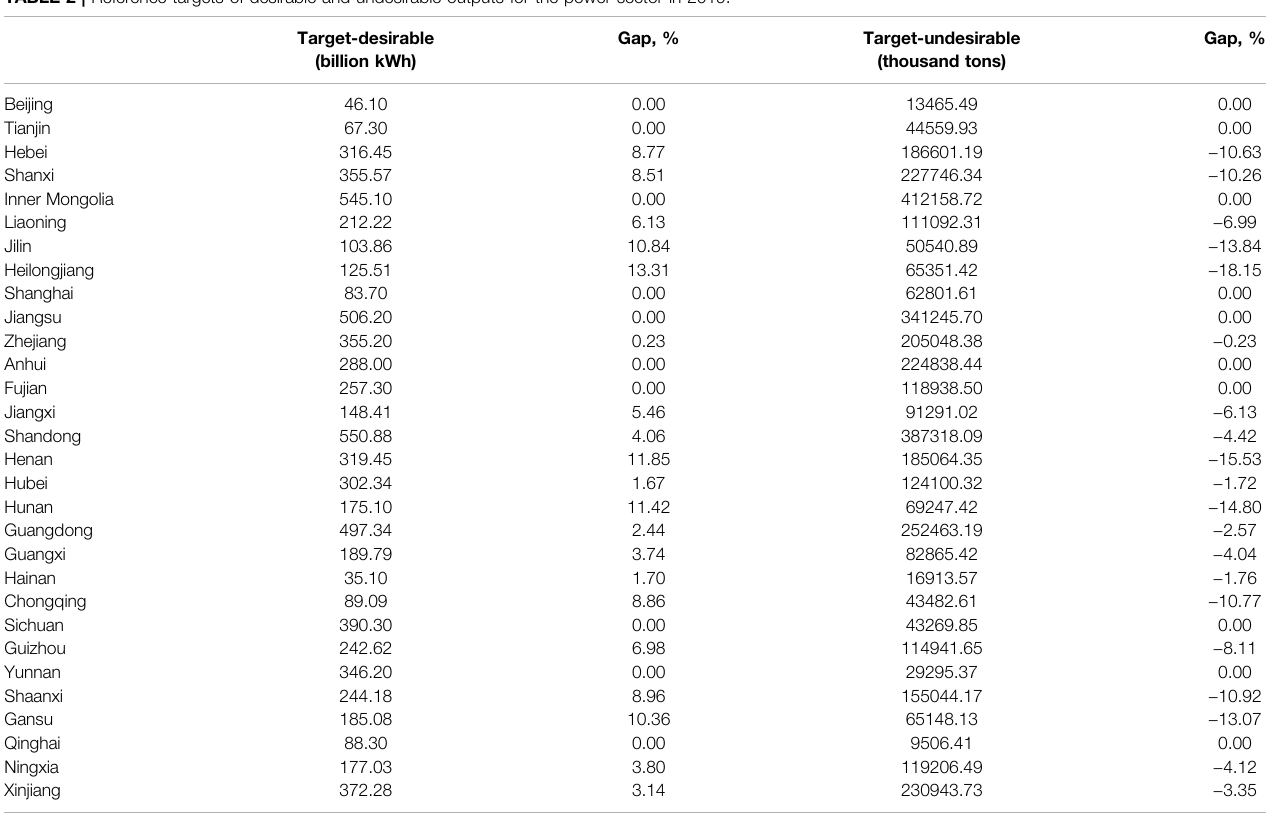
TABLE 2 | Reference targets of desirable and undesirable outputs for the power sector in